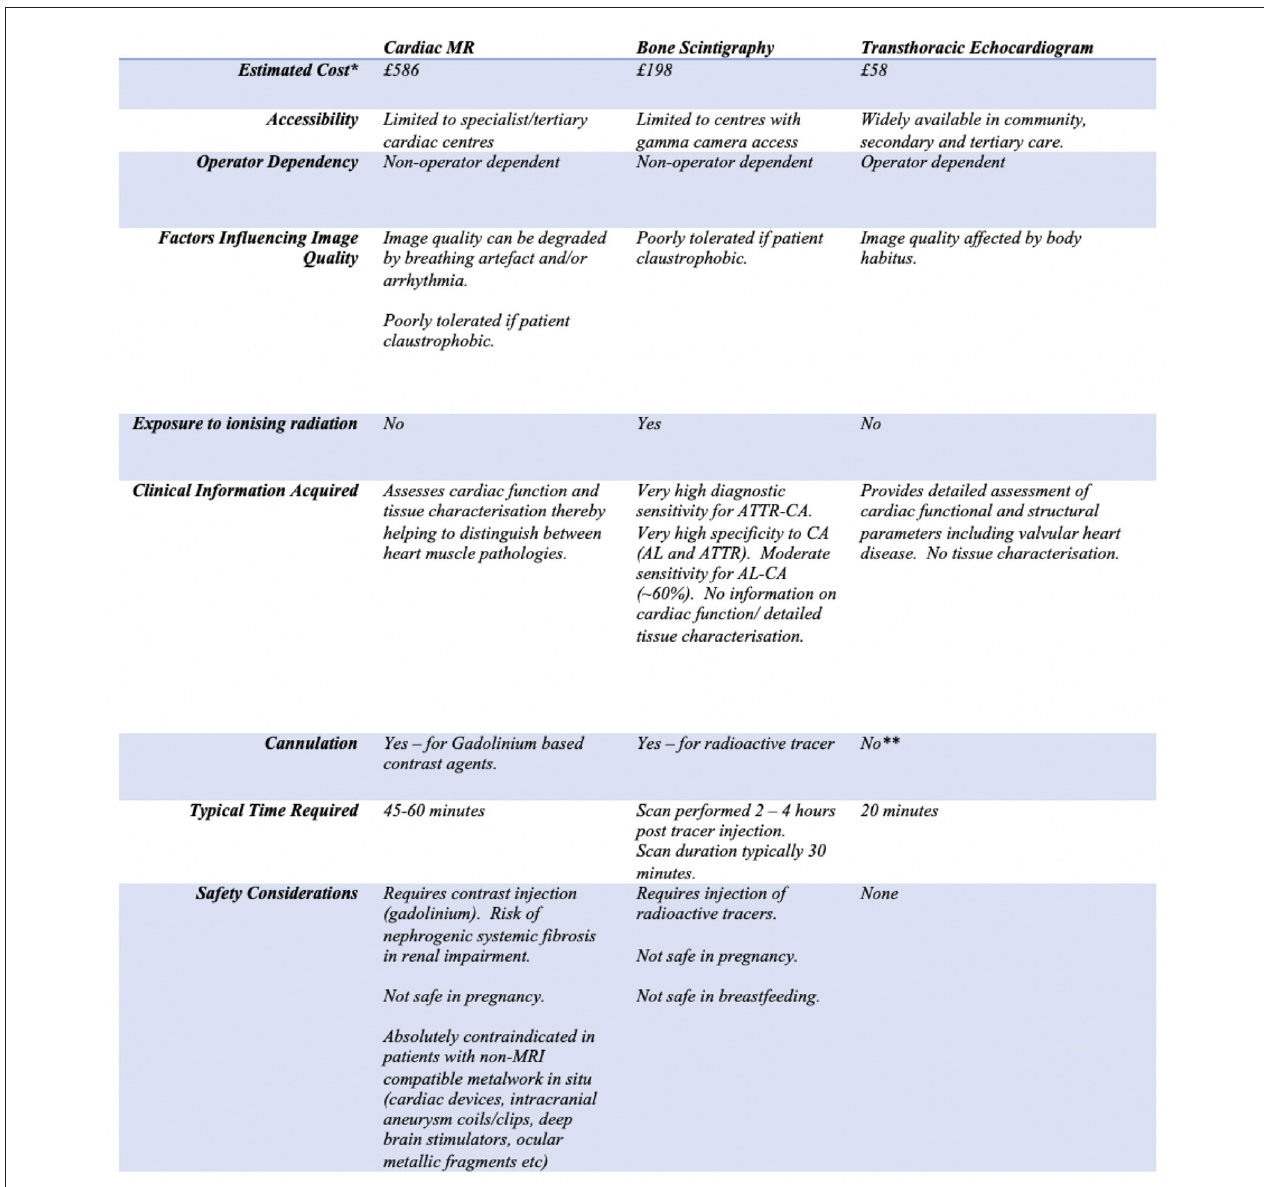
FIGURE 5 | Table highlighting the individual limitations and strengths of cardiac magnetic resonance, bone scintigraphy and echocardiography in the context of assessing patients with cardiac amyloidosis (*costing estimates based on UK National Health Service Tariffs 2020/2021, estimate includes cost of reporting scans, **whilst cannulation is required for contrast echocardiography, this is not routinely indicated when assessing for